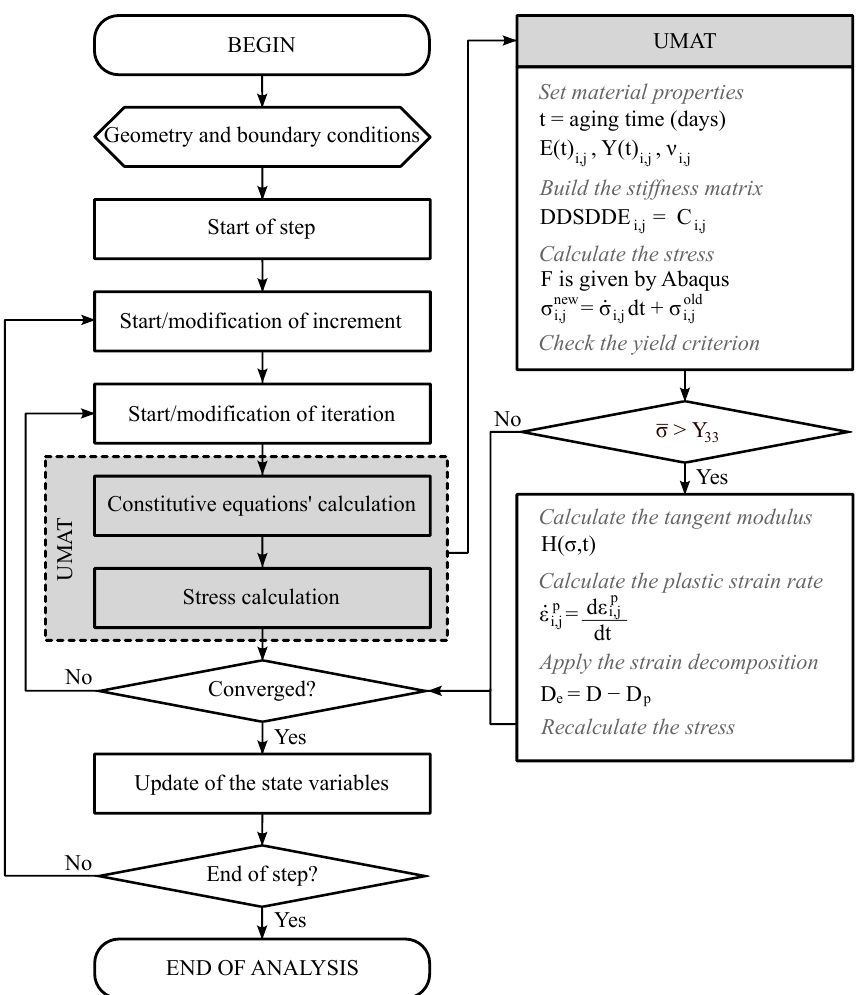
Figure 5. Flowchart of the UMAT application on Abaqus